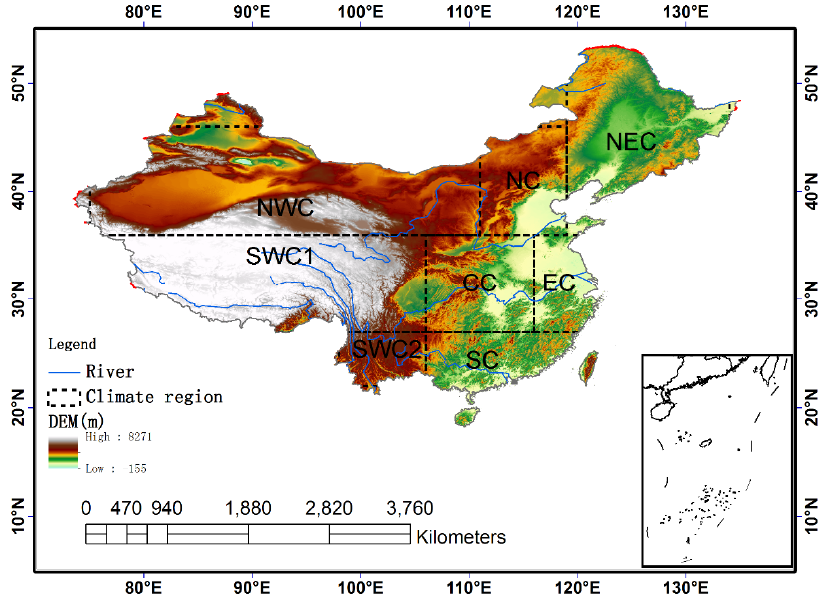
Figure 1. Eight subregions in China. NEC: Northeast China; NC: North China; EC: East China; CC: Central China; SC: South China; SWC1 / TP: Tibetan Plateau; SWC2 / SWC: Southwest China; and NWC: Northwest China.